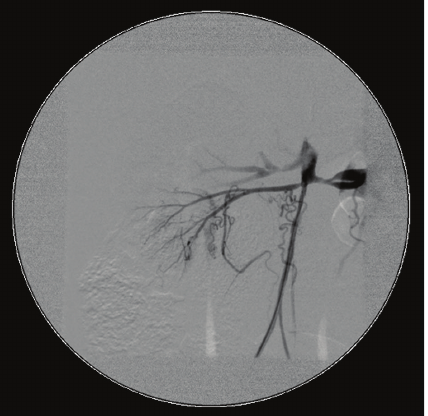
Figure 2: Angiography demonstrating the thread-like aorta up to the level of the common iliac